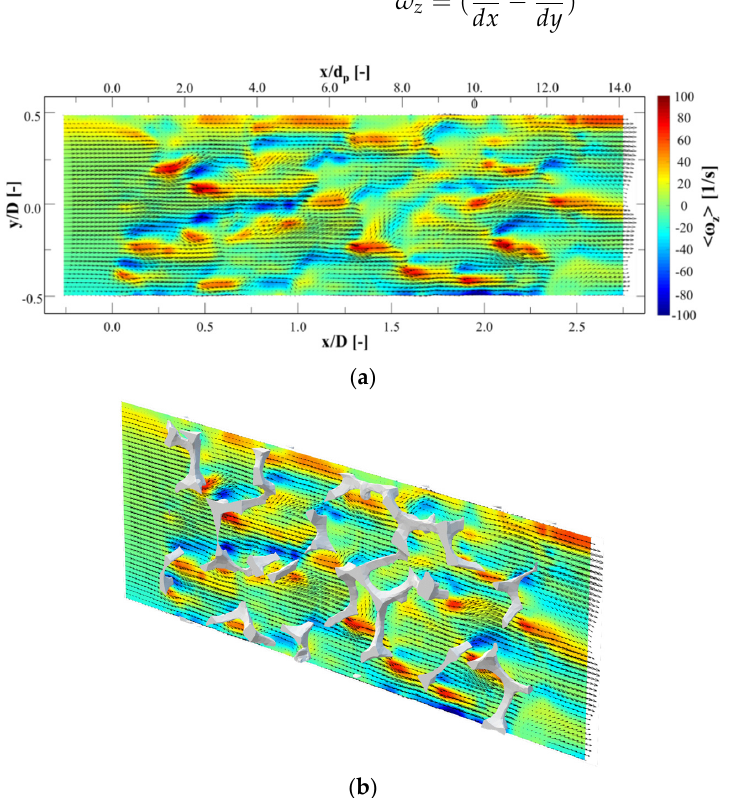
Figure 9. Contours of vorticity at z = 0 D with superimposed vector fields: ( a ) without and ( b ) with overlay of metal foam